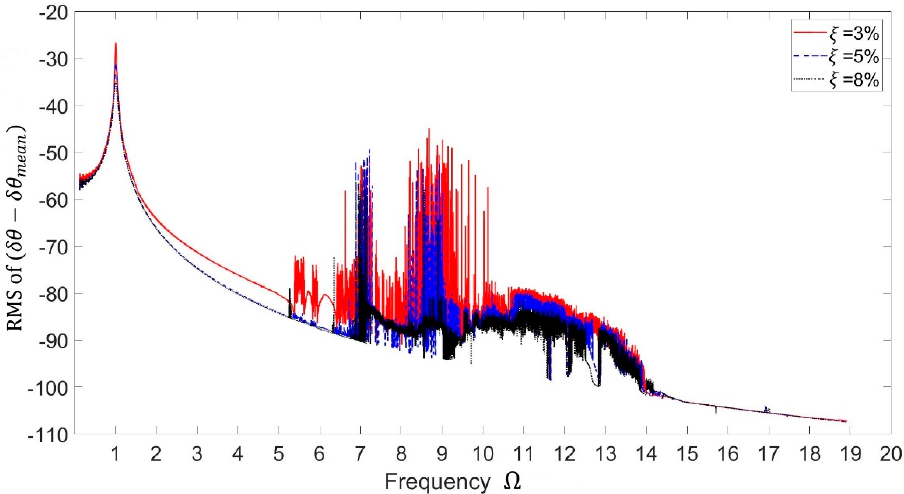
Figure 6. The frequency responses with different damping ratios.